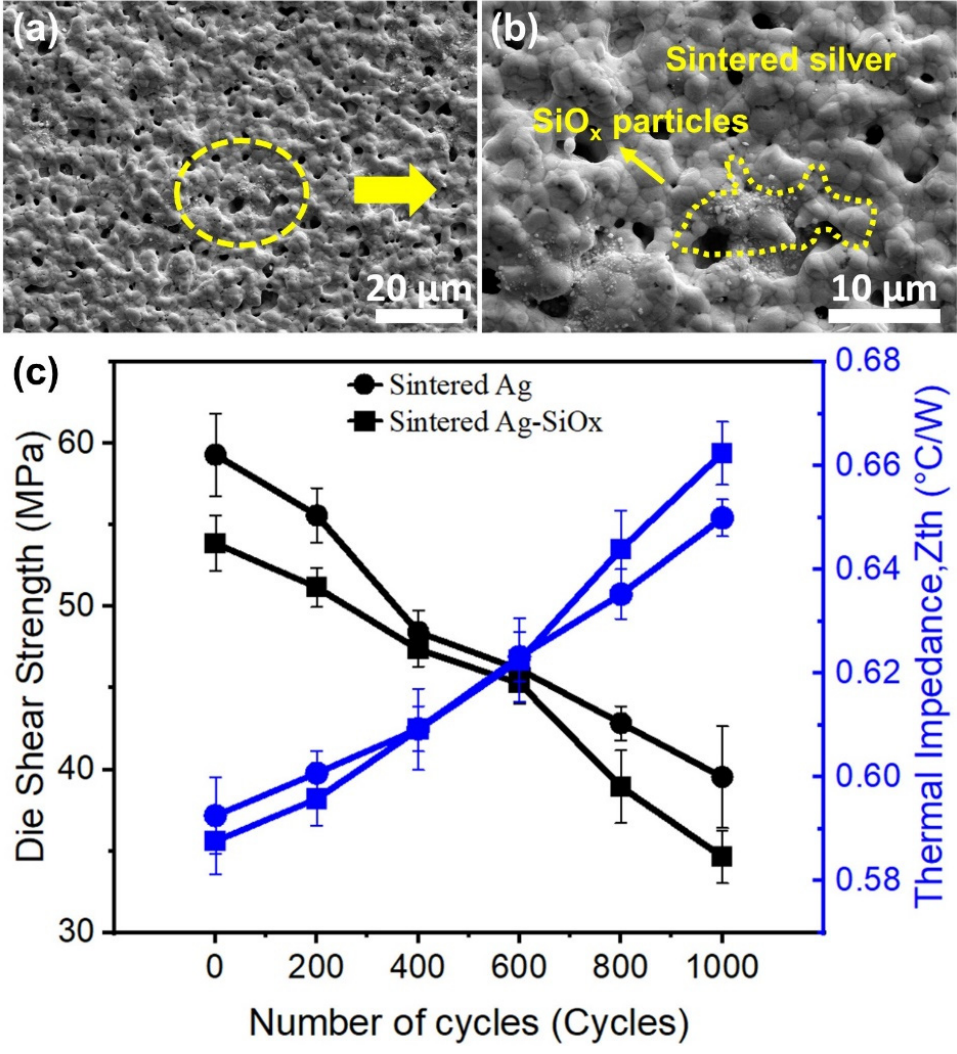
Figure 3. ( a ) Microstructures of as-sintered nano-Ag-SiO x ; ( b ) the corresponding magnified image; ( c ) the thermal impedance of sintered nano-Ag-SiO x variation with the number of thermal shocking cycles.